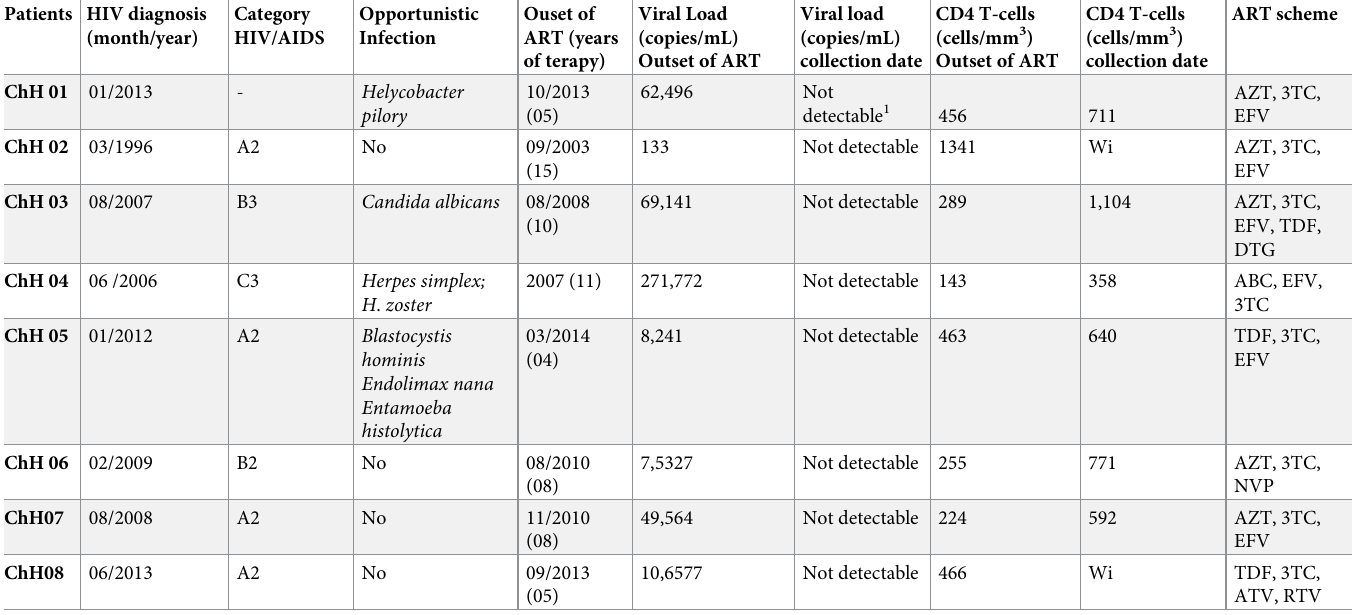
HIV - human immunodeficiency virus; ChH - patient co-infected Chagas disease and HIV; AIDS - acquired immunodeficiency syndrome; ART - antiretroviral therapy; AZT - zidovudine; 3TC - lamivudine; NVP - nevirapine; ABC - abacavir; EFV - efavirenz; TDF - tenofovir; ATV - atazanavir; DTG - dolutegravir; RTV - ritonavir. 1 Not detectable - below detection limit of 50 viral particles/mL; Wi - without